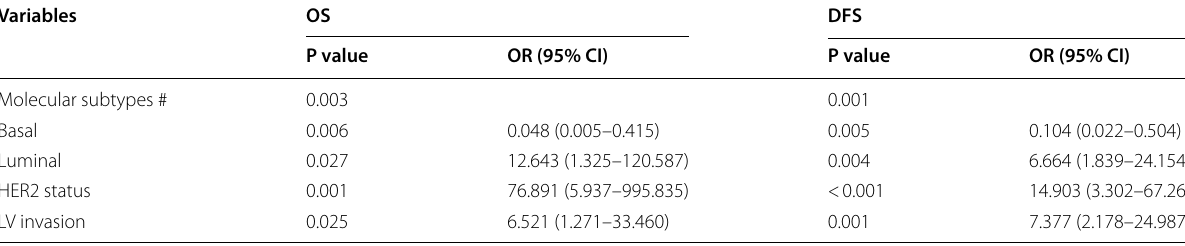
* P values less than 0.5 was considered statistically